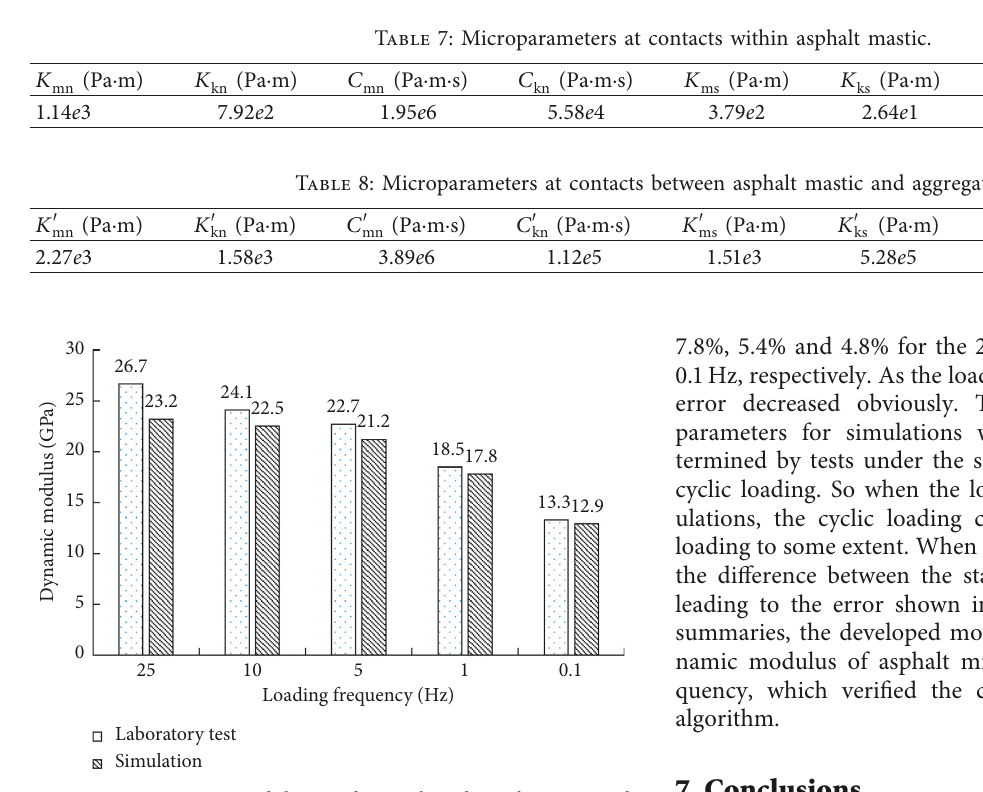
Figure 13: Dynamic modulus prediction based on the proposed models.